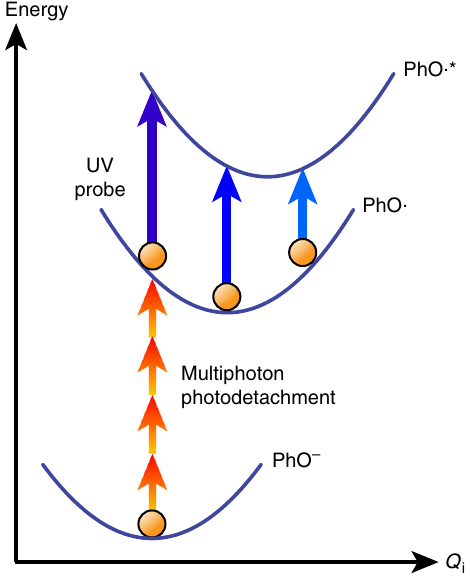
Fig. 2 Vibrational wave packet generation by multiphoton photodetachment. Photodetachment of aqueous phenoxide by a strong- fi eld, few-cycle laser pulse (red arrows) launches vibrational wave packet motion in the phenoxyl radical, which is subsequently probed by its time- dependent UV absorption (blue arrows). The potential energy curves of